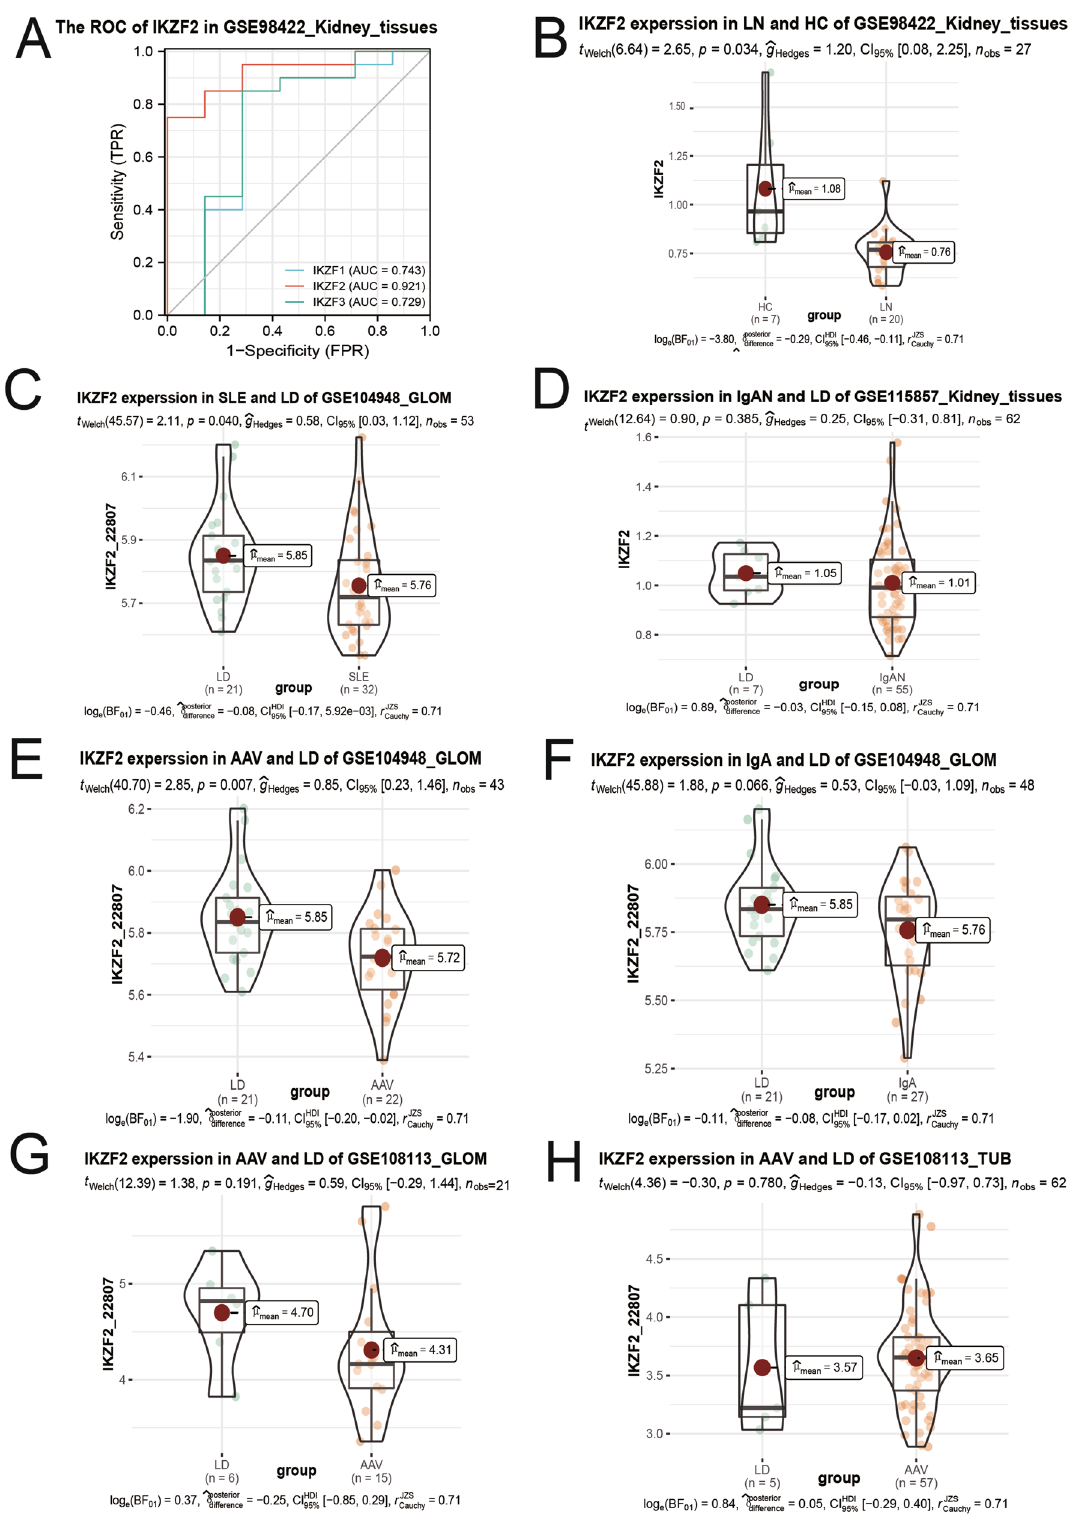
Figure 9. Validation with other GEO datasets. ( A ) ROC curve of IKZF family expression level to distinguish LN samples and LD in the dataset of GSE98422. ( B \ C ) Comparison of IKZF2 expression value between LN/LD samples by datasets of GSE98422 and GSE104948. ( D \ F ) Comparison of IKZF2 expression value between IgA nephropathy and normal by datasets of GSE104948 and GSE115857. ( E \ G \ H ) Comparison of IKZF2 expression value between ANCA associated vasculitis and normal by datasets of GSE104948 and